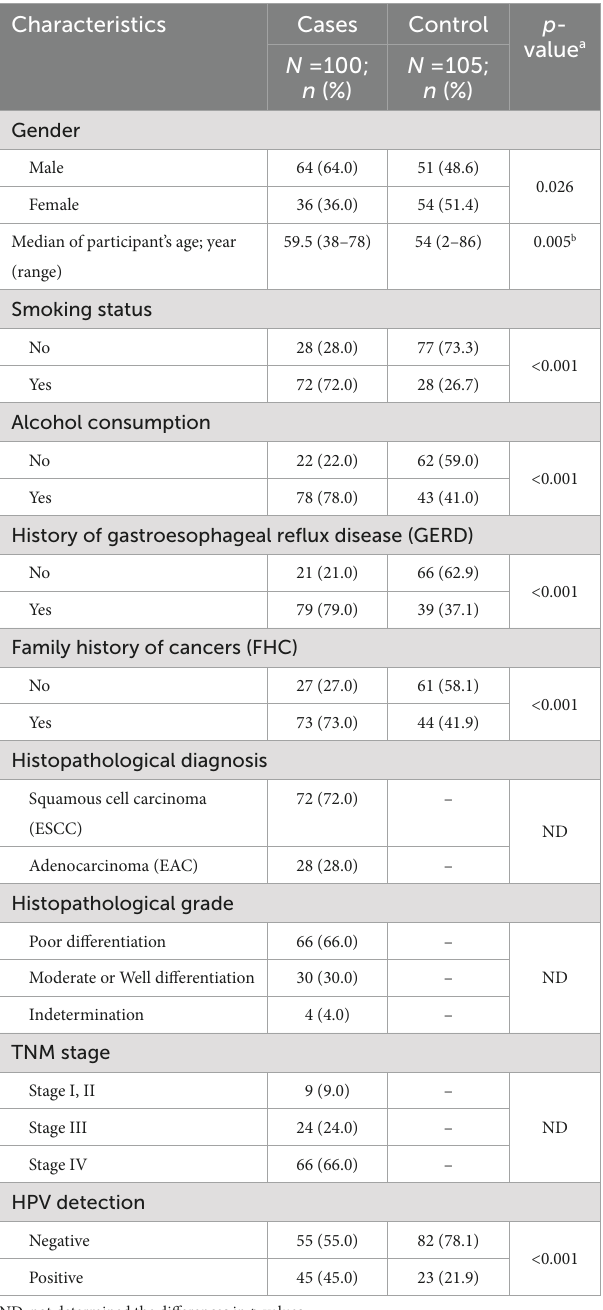
TABLE 1 Clinico-demographic profile of esophageal cancer patients and control participants.